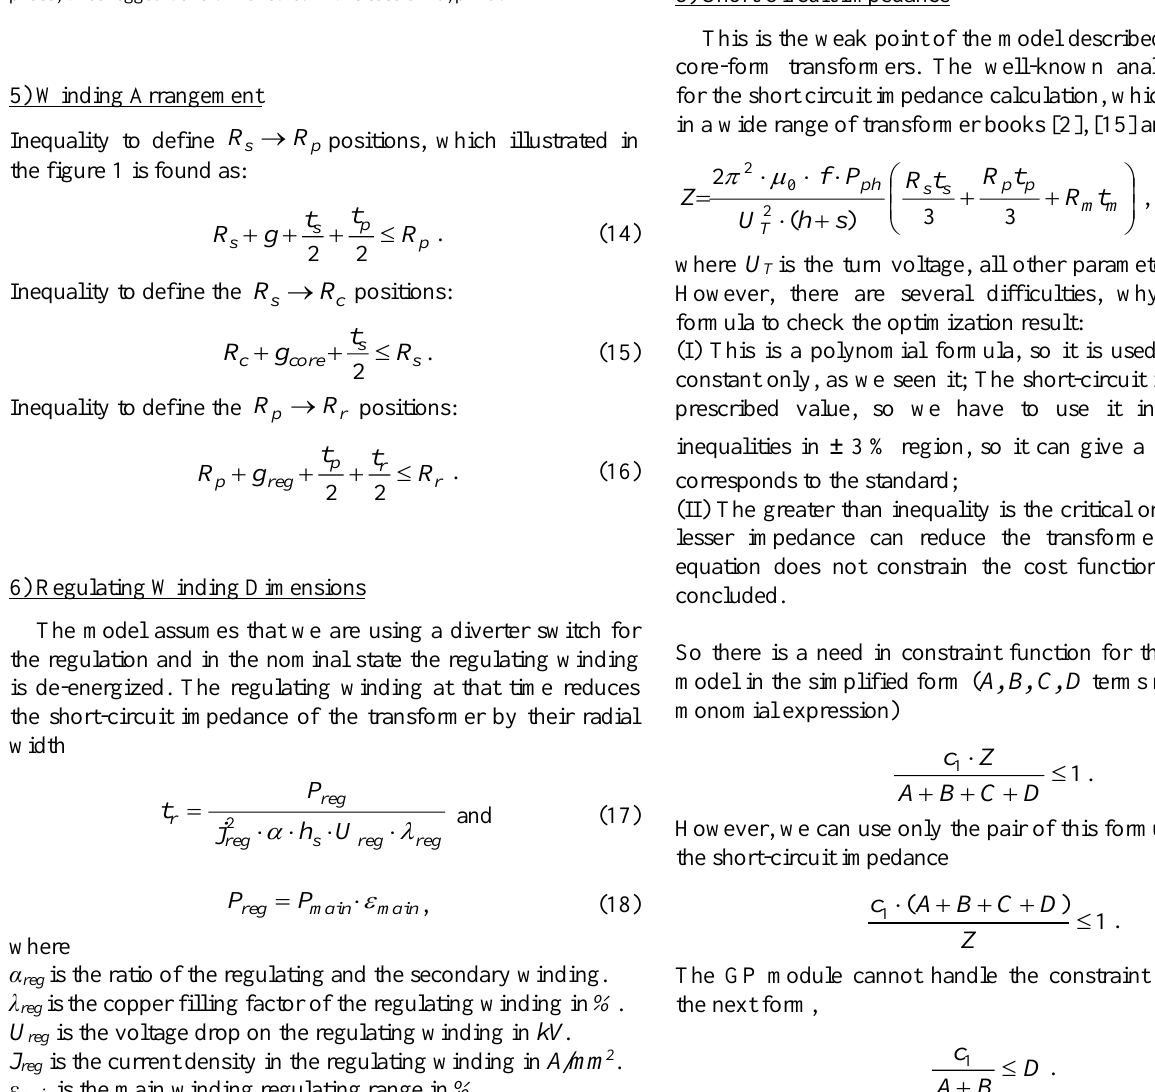
Fig. 2. Illustrates the different summarized parts in the case of common three phase, three legged transformer core. In this case c = 6, p =